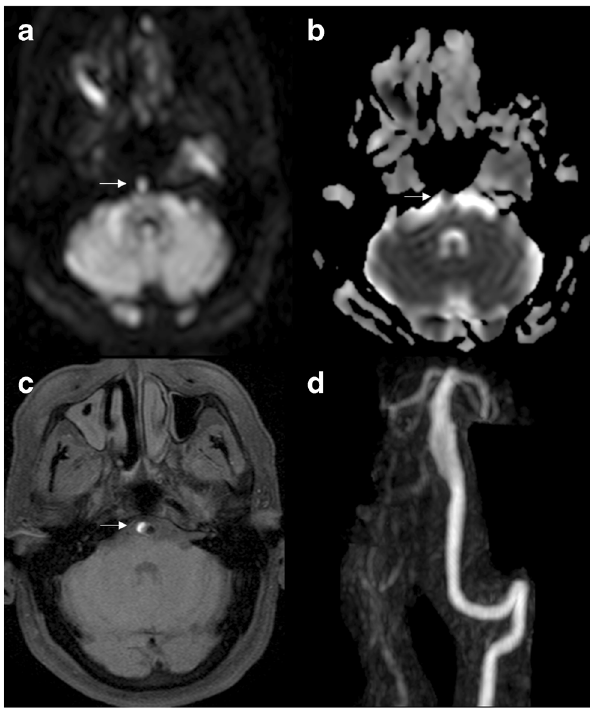
Fig. 3 Arterial dissection. DWI ( a ), ADC ( b ), non-contrast FAT SAT T1 ( c ) and coronal MIP reconstruction of the basilar artery ( d ) demonstrate a dissection with mural haematoma represented by the B crescent sign ^ (arrows), which shows restricted diffusion and hyperintensity on